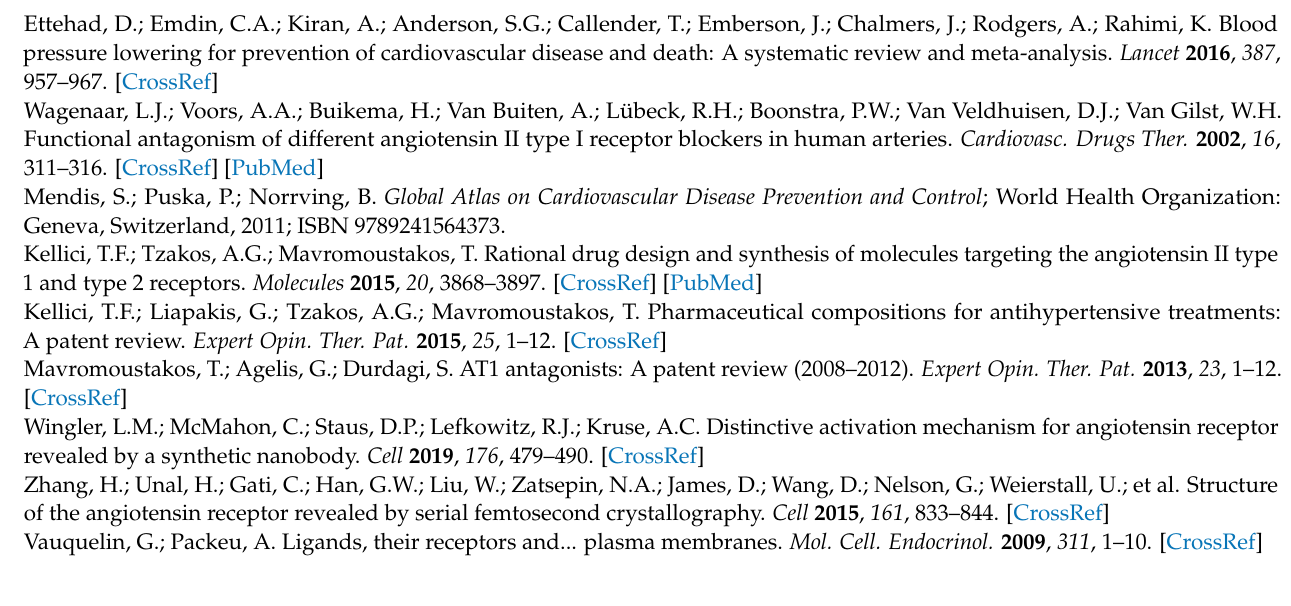
DOPC loaded with “cyclodextrin-irbesartan”